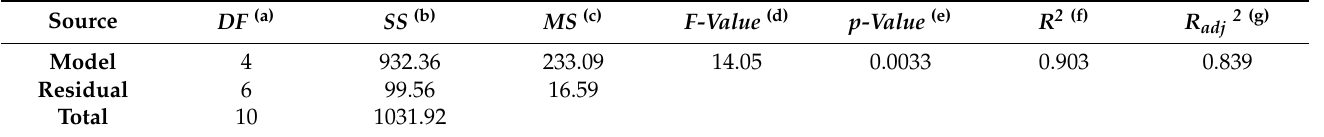
Table 4. Analysis of variance (ANOVA) for the fi tt ed model 𝑌(cid:3552) (𝑥 (cid:2869) , 𝑥 (cid:2870) )